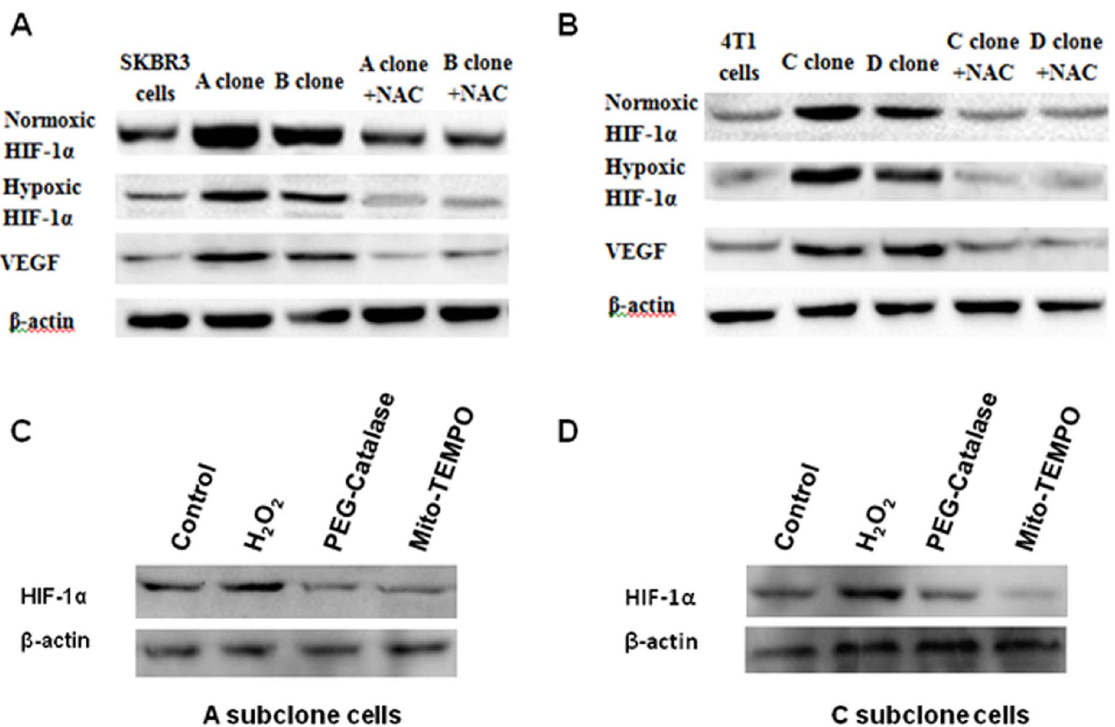
Figure 5. ROS promoted HIF-1 a and VEGF expression in subclone cells. A, ROS led to increased expression of HIF-1 a and VEGF in SKBR3 subclones. SKBR3 subclones showed higher normoxic and hypoxic HIF-1 a level than the parental SKBR3 cells. VEGF expression was more increased in SKBR3 subclones than in the parental SKBR3 cells. HIF-1 a and VEGF expression in SKBR3 subclone were significantly inhibited by NAC. B, ROS led to increased expression of HIF-1 a and VEGF in 4T1 subcloneswhereas NAC was able to attenuate the ROS induced expression of HIF-1 a and VEGF. C–D, H 2 O 2 promoted HIF-1 a expression, while PEG-catalase and mito-TEMPO inhibited HIF-1 a expression in A clone (C) and C clone (D).